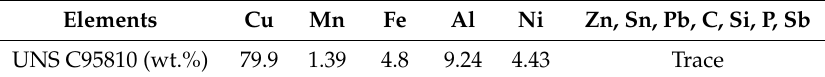
Table 1. Composition of the UNS C95810.